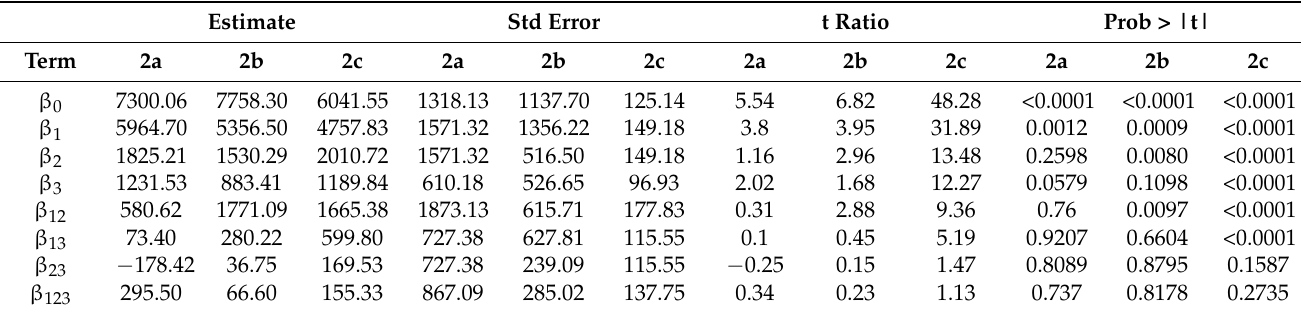
Table 3. Equation (4) coefficient estimates, standard error, t ratios, and p -values for the three models depicted in Figure 1, with 2a corresponding to low Bis, high silica nanoparticles, 2b corresponding to high Bis, high silica nanoparticles, and 2c corresponding to low Bis, low silica nanoparticle models, respectively. Std Error Prob > |t|